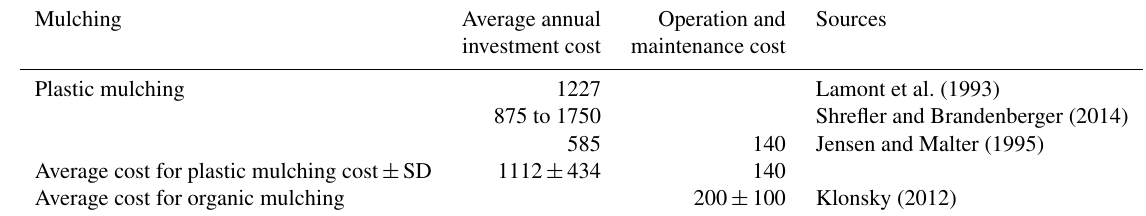
Table C1. Estimates for the cost of mulching (USDha − 1 yr − 1 ) .